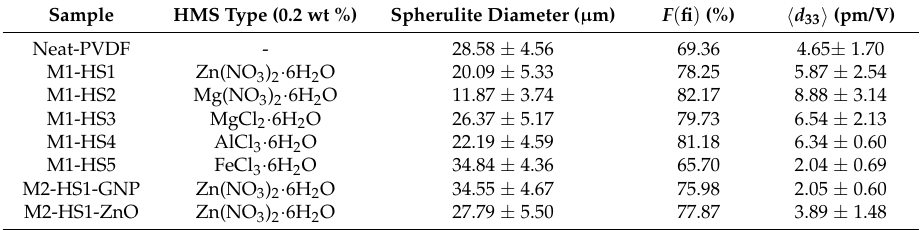
Table 2. List of the produced PVDF films, including the type of HMS dissolved; the average values of the spherulite diameter estimated from FE-SEM images; the relative fraction of the β -phase, F( β ), estimated from FT-IR spectra; and the average piezoelectric coefficient (cid:104) d 33 (cid:105) obtained through PFM measurements.